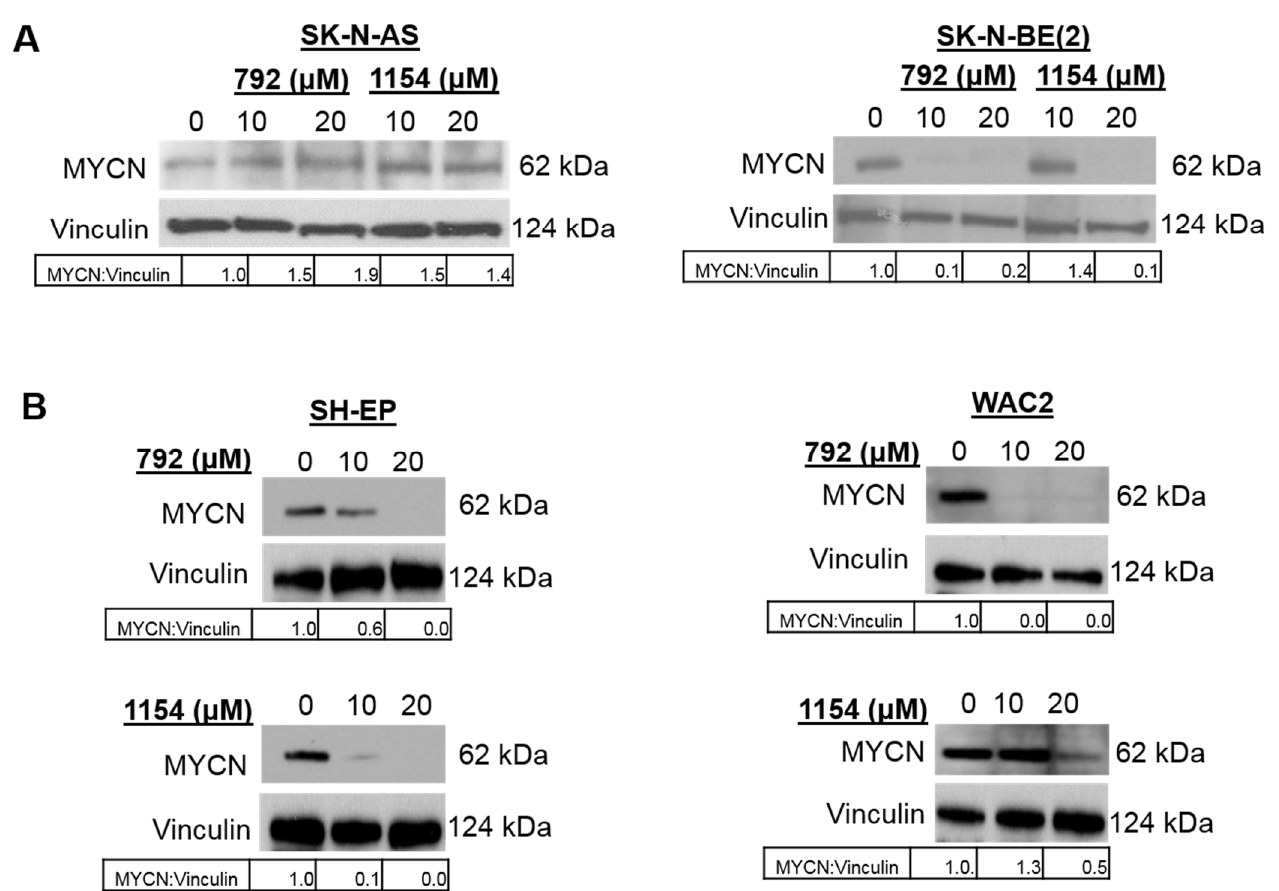
Figure 7. PP2A activation resulted in a decrease in MYCN expression. ( A ) Immunoblotting was completed on whole cell lysates of SK-N-AS, and SK-N-BE(2) cells following treatment with increasing doses of 792 or 1154 for 24 h. Treatment with 792 and 1154 resulted in decreased MYCN expression in SK-N-BE(2) cells ( right panel ), while there was an increase in MYCN expression in SK-N-AS cells ( left panel ). ( B ) Immunoblotting was completed on whole cell lysates of two isogenic MYCN neuroblastoma cell lines, SH-EP ( left panel ) and WAC2 ( right panel ). Treatment with 792 or 1154 resulted in decreased MYCN expression. Vinculin was used as a loading control, and densitometry was used to quantify MYCN expression relative to vinculin expression. The uncropped western blot figures were presented in Figure S7.